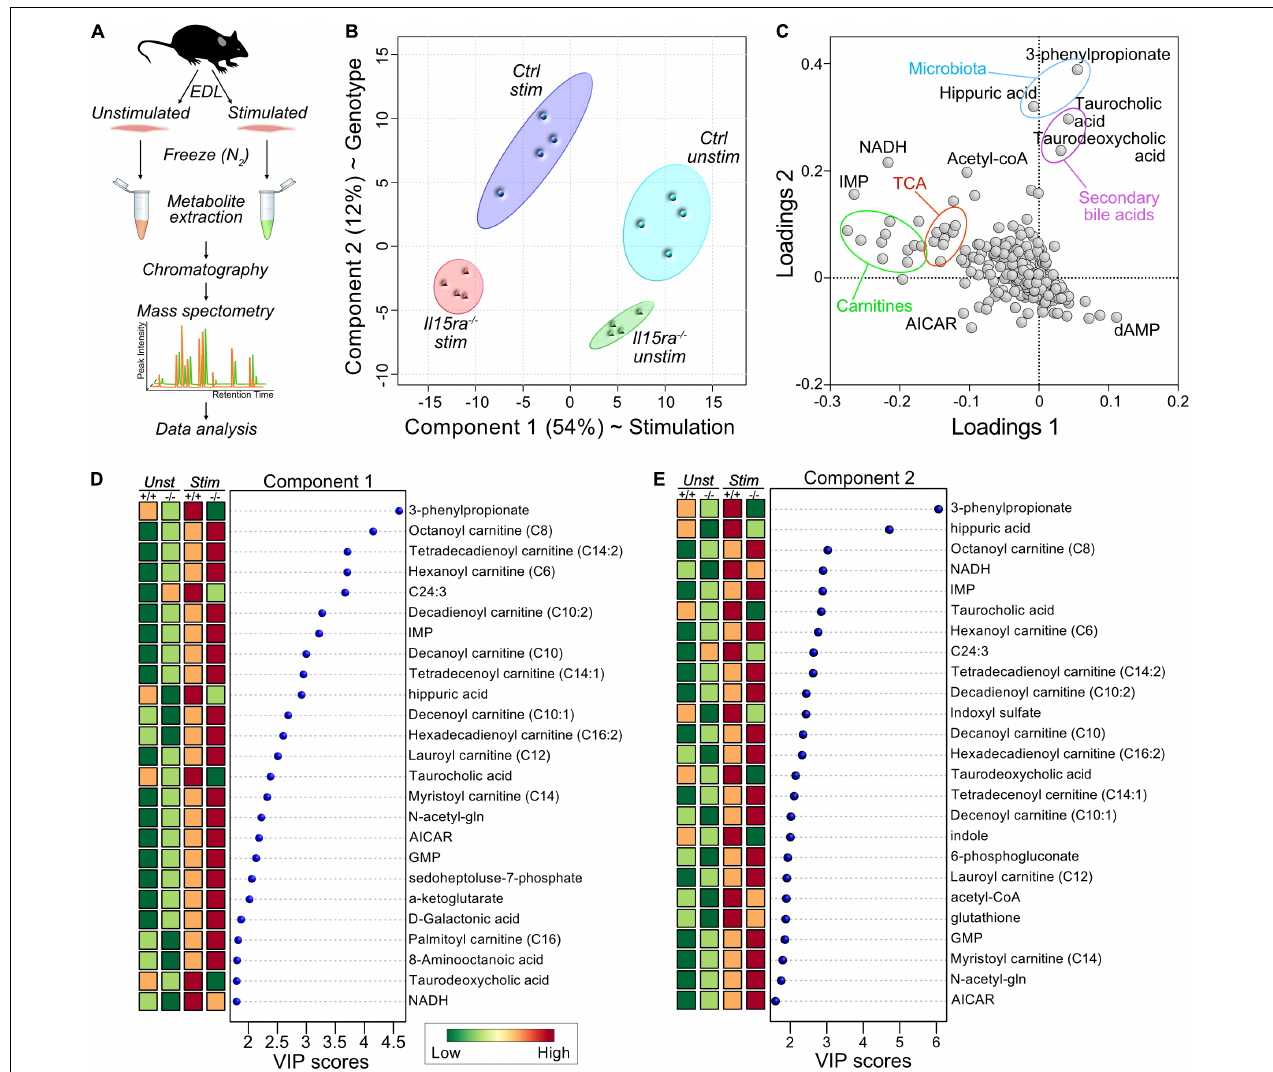
FIGURE 3 | Supervised multivariate analysis. (A) Diagram of the experimental pipeline adopted for the study. (B) Partial Least Square Discriminant Analysis (PLS-DA) plot of the metabolomics data. (C) Loadings plot for the principal components selected by PLS-DA. (D,E) Ranked representation of Variable Importance in Projection (VIP) scores for the features contributing to the variance of component 1 (D) and 2 (E) , according to PLS-DA.